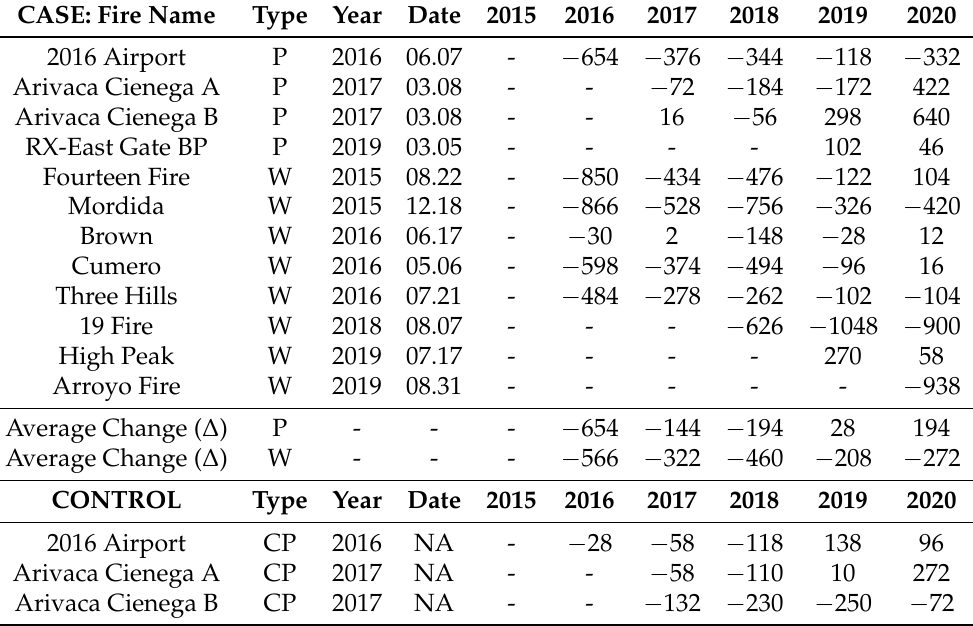
Table A3. The yearly estimated change ( ∆ ) of fine-fuels (kg/ha) within burn perimeters after wildfire (W) and prescribed (P) fires at BANWR against 1-km buffered control (C) areas around fire perimeters (some ignition dates do not align with calendar date but rather to pre- or post-imagery